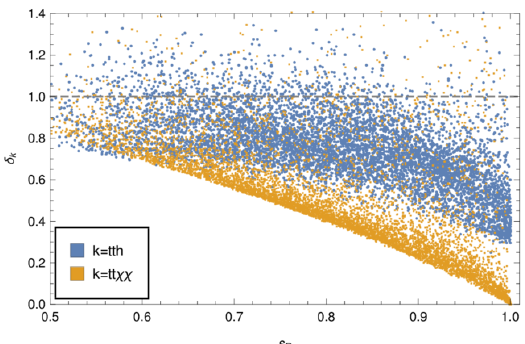
Figure 5 . Corrections from top partner mixing to the e(cid:11)ective t (cid:22) th and t (cid:22) t(cid:31) (cid:3) (cid:31) couplings, de(cid:12)ned as (cid:14) tt(cid:31)(cid:31) (cid:17) c tt(cid:31)(cid:31) =c nl (cid:27) m and (cid:14) tth (cid:17) ( c tth (cid:0) 1) = ( c nl (cid:27) m (cid:0) 1), as functions of the compositeness fraction s R tt(cid:31)(cid:31) tth of the right handed top (see eq. (B.13) for its de(cid:12)nition). The gray dashed line indicates the pure sigma model result, where top partner mixing is neglected. The points shown are obtained from